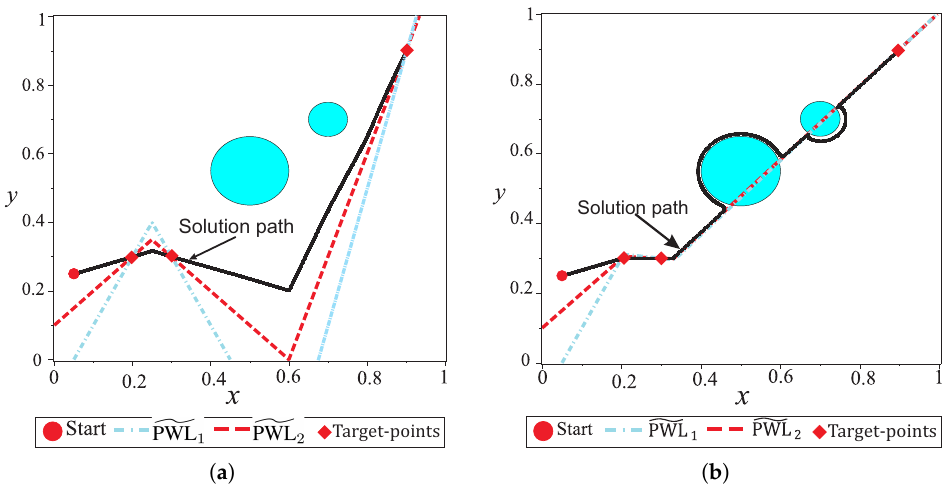
Figure 9. Selection of breakpoints for the (cid:103) PWL functions. ( a ) Breakpoints placed far from target-points. ( b ) Breakpoints placed close to